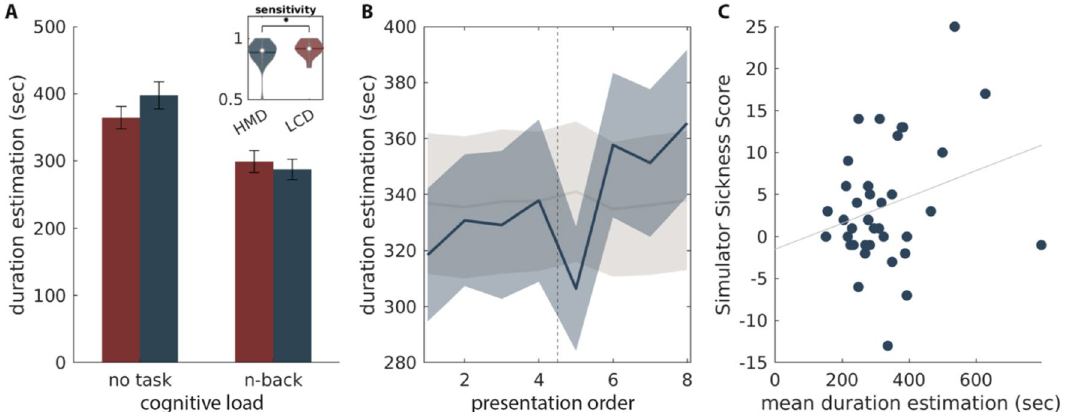
Figure 3. ( A ) Mean estimation as interaction between immersion and cognitive load. Inset Performance (sensitivity index A’) during the n-back task for the two immersion levels. ( B ) Average time estimation over the course of the experiment, regardless the experimental condition. In gray label shuffled permutation, shaded area represents standard deviation. ( C ) Scatter plot of the mean duration estimation during HMD trials and the SSQ score. Each dot represents one